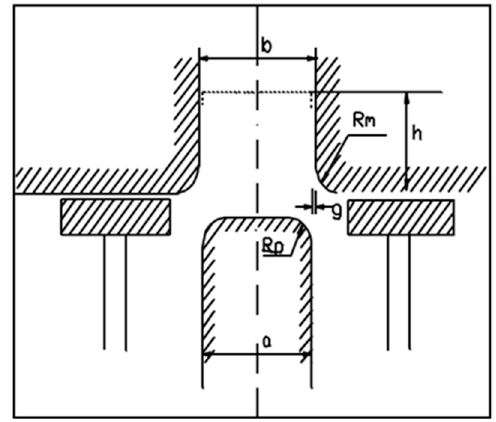
Figure 2. Omega stamping die.